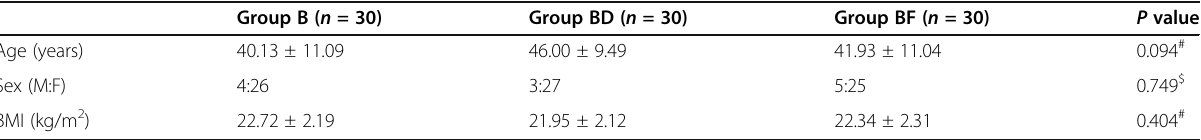
Table 1 Demographic variables